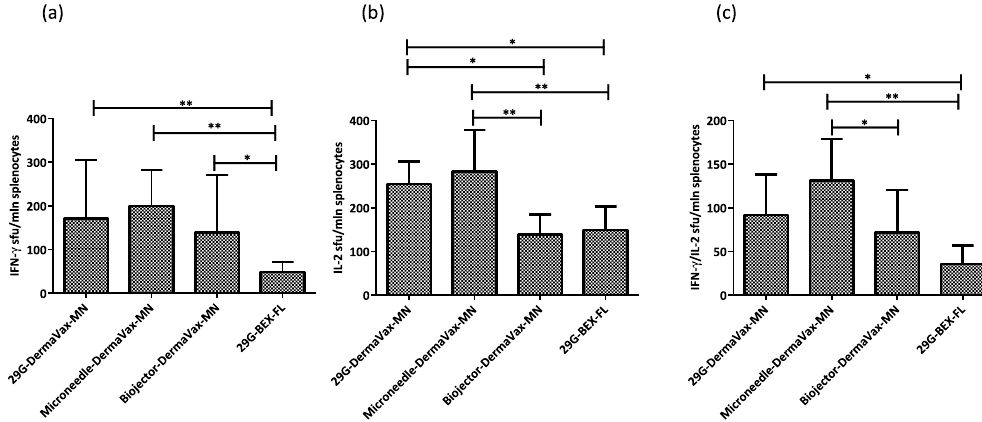
Figure 5. Cellular immune responses after RT gene delivery by intradermal injections with 29 G needles or microneedles with electroporation using penetrating electrodes. BALB/c mice (n = 6–8) were immunized with two intradermal injections with a mixture of Luc/RT1.14opt-in encoding plasmids (1:1 w/w, with a total of 2 × 20 µ g DNA per mouse) using an insulin syringe with a 29G needle (29G-Dermavax-MN), microneedles (Micronjet 600, Nanopass) (Microneedle-Dermavax-MN), or a Biojector 2000 (Biojector-Dermavax-MN) and electroporated using Dermavax with multi-needle (MN) electrodes or injected with a mixture of Luc/RT1.14- opt-in encoding plasmids using an insulin syringe with a 29G needle and electroporated with the BEX machine and flat electrodes (29G-BEX-FL). At 21 days post immunization, mice were sacrificed and splenocytes were isolated and subjected to in vitro stimulation with peptide representing aa 528–543 of HIV-1 RT, and cytokine secretion was assessed by dual IFN- γ /IL-2 Fluorospot. The results are shown as the average number of cells, registered as signal-forming units (sfu) per million splenocytes secreting IFN- γ ( a ) IL-2 ( b ) and IFN- γ /IL-2 ( c ) and the error bars represent the SD. All assays were performed in duplicate. * p < 0.05; ** p < 0.01. Statistical comparisons were performed using Kruskal–Wallis and Mann–Whitney